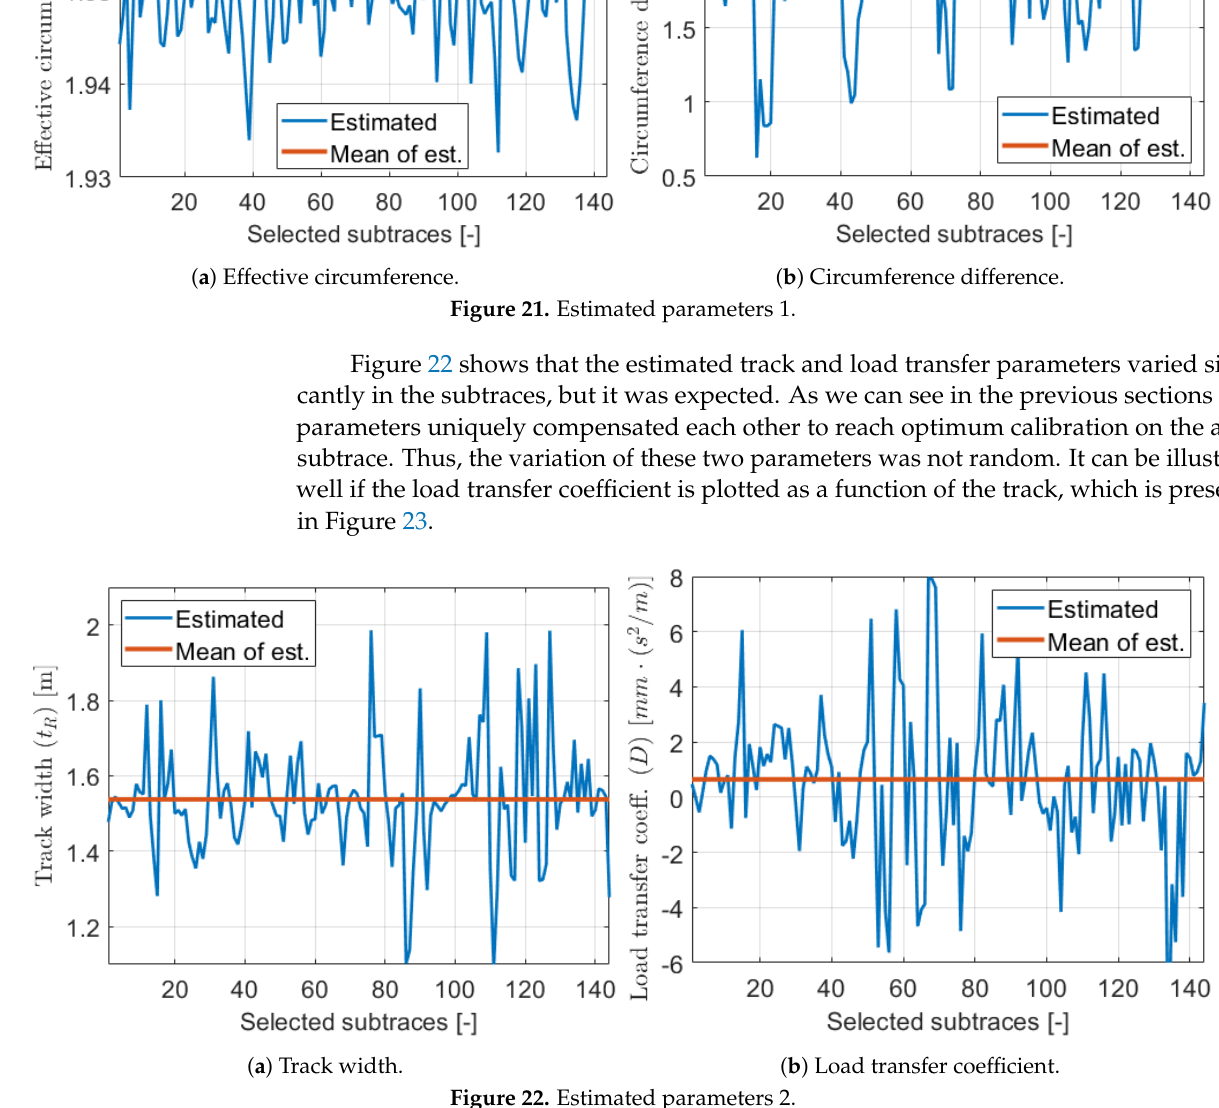
Figure 22. Estimated parameters